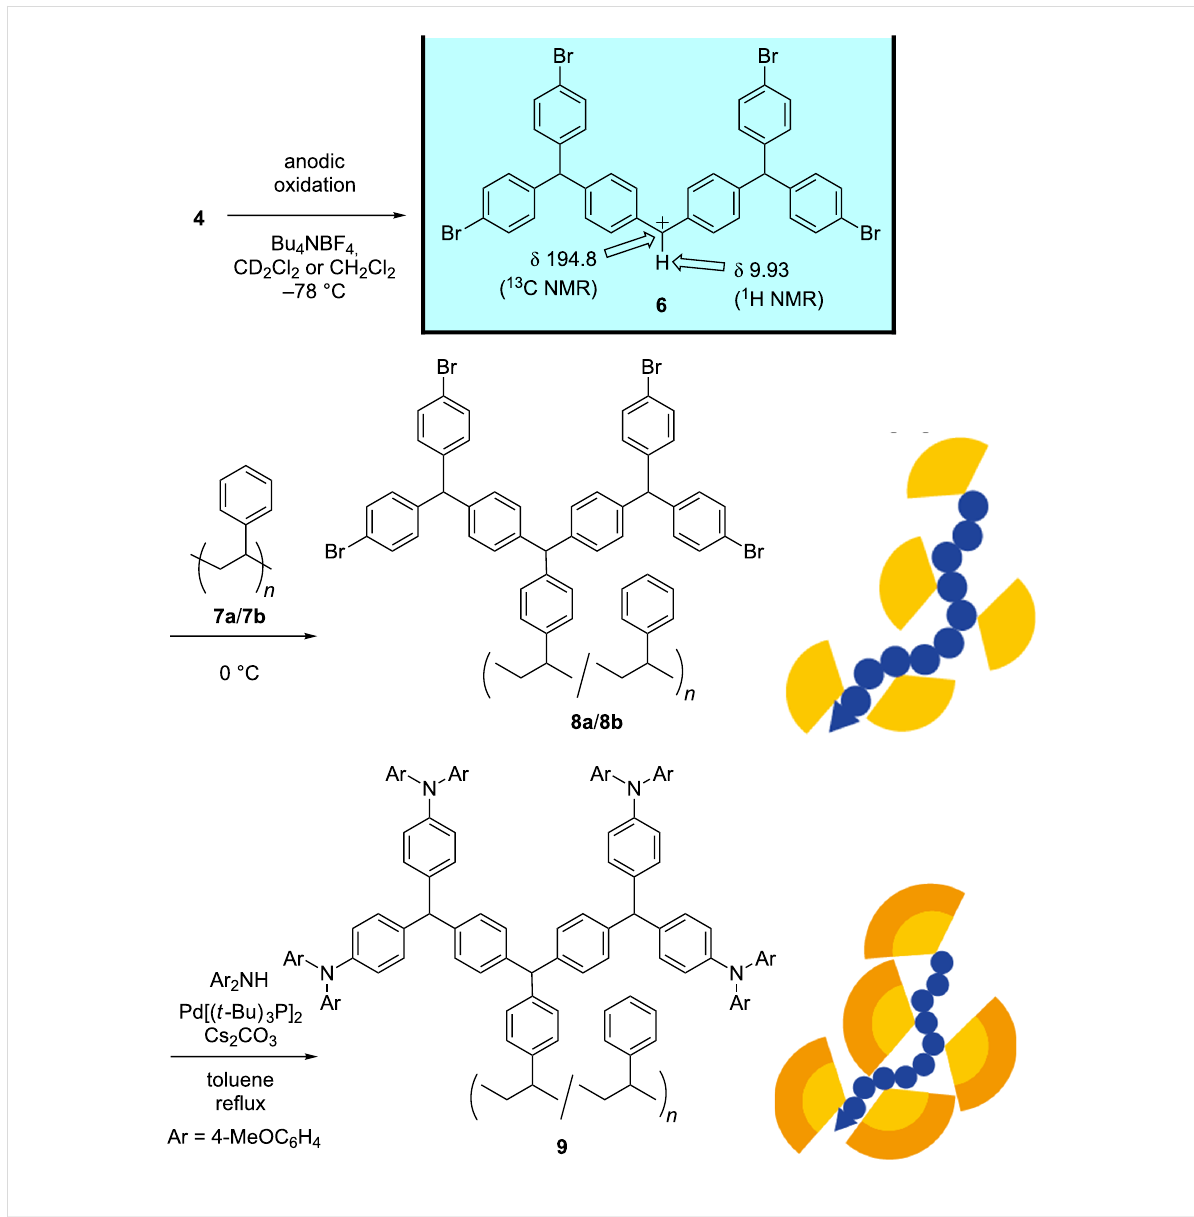
Figure 3: Preparation of dendronized polystyrenes having peripheral diarylamino